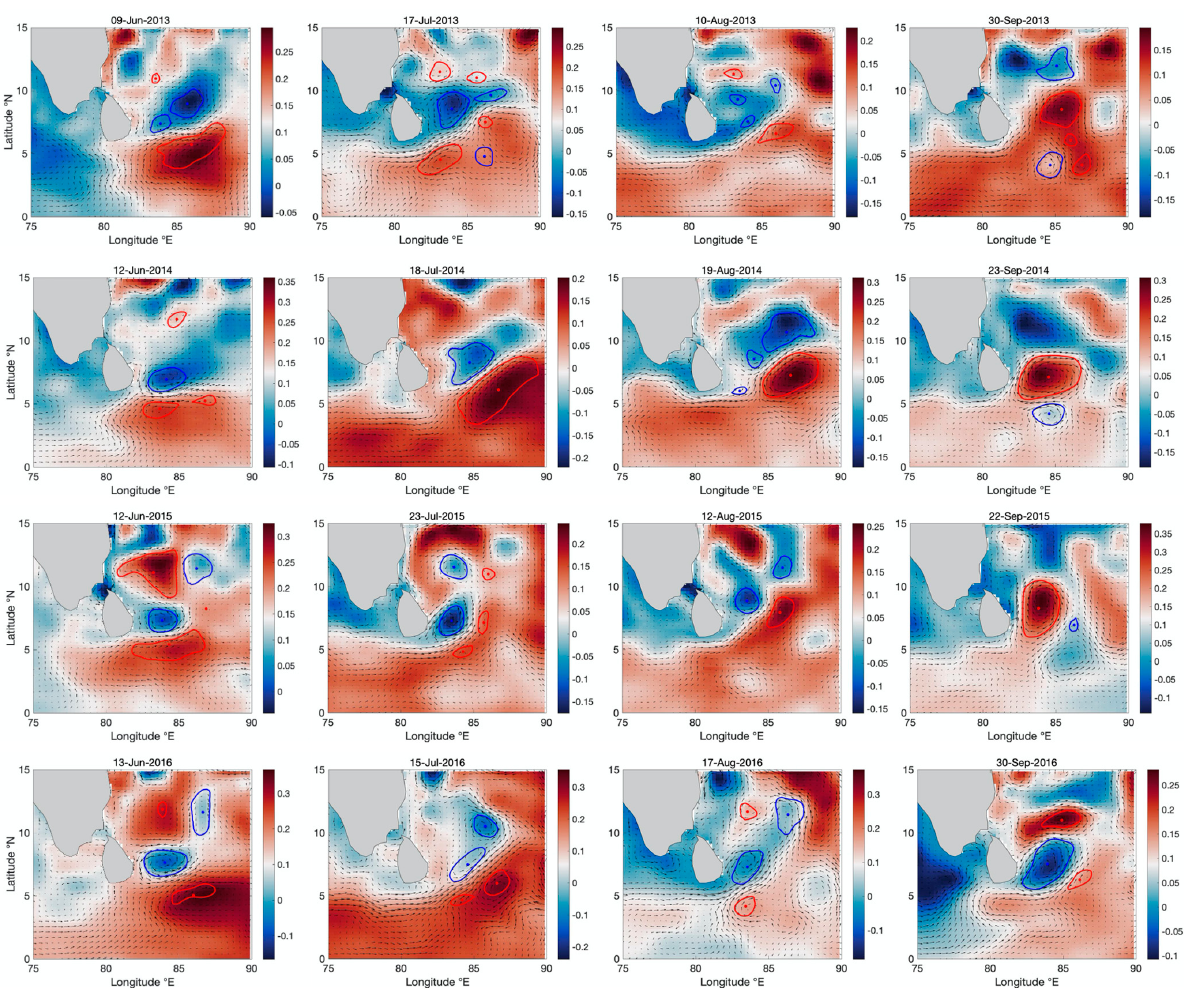
Figure 9. Snapshots of eddy dipole in the SLD region during June–September 2013–2016. Shaded areas show SSHA. Arrows denote geostrophic current. Blue and red contours denote the size of CEs and ACEs, respectively. Blue and red points denote the center of the CEs and ACEs, respectively.